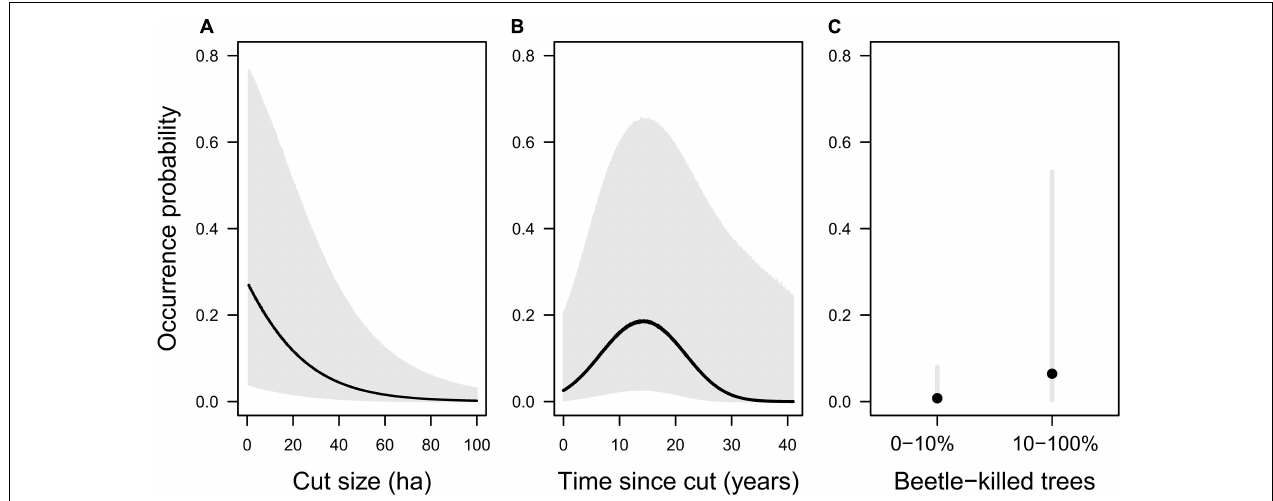
FIGURE 2 | Probability of olive-sided flycatcher occurrence (black) with 90% prediction intervals (gray) according to top-ranked models. (A,B) Top ranked model in the first set (Post-cut), for points within 50 m of a clearcut: Occurrence ∼ Cut size + Time since cut + Time since cut 2 + 1| Year. (C) Top-ranked model in the second set (Uncut), for points > 50 m from a clearcut: Occurrence ∼ mountain pine beetle + 1| Year). We allowed (A) cut size, (B) time since cut, and (C) mountain pine beetle, to vary, while holding the other fixed effects near their optima ( A: time since cut = 15 years, B: cut size = 10 ha). The predicted value and prediction interval for each value of the predictor variables represents the mean of 50,000 simulations using the predictInterval command in the merTools package of R, and includes the uncertainty related to residual variance, the uncertainty in the fixed coefficients, and some of the uncertainty in the variance parameters for the random effect of year (Knowles and Frederick,